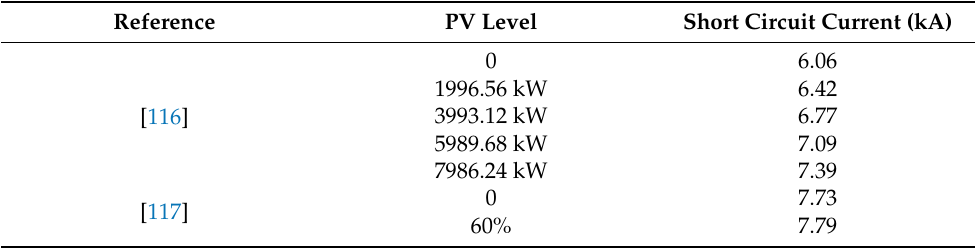
Table 2. Variation of short circuit currents according to different PV penetration